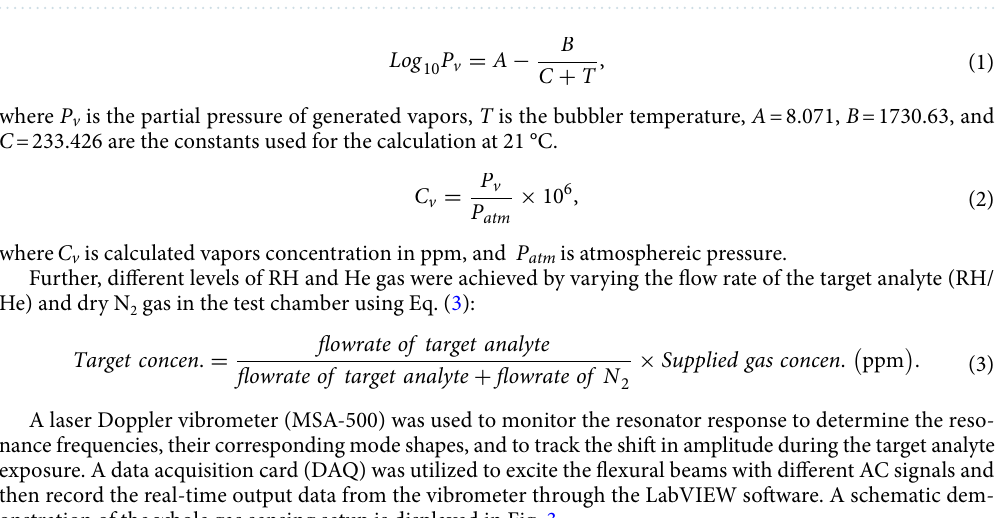
Figure 3. Schematic illustration of the gas sensing